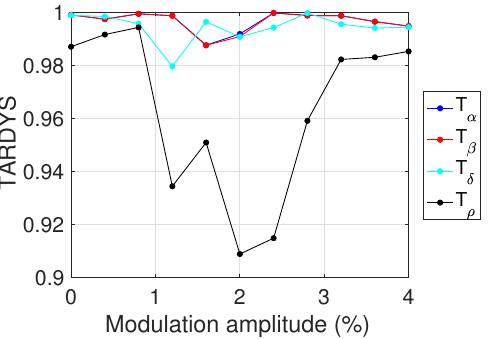
Figure 2. TARDYS quantifiers of the photonic neuron (see main text for